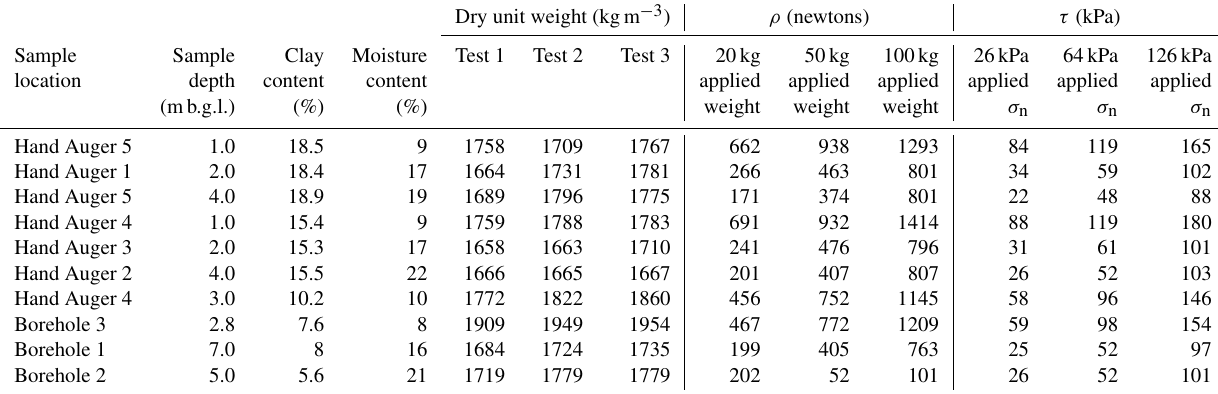
Table 2. Direct shear test variables for hand auger and borehole samples at various depths and displaying various moisture contents.